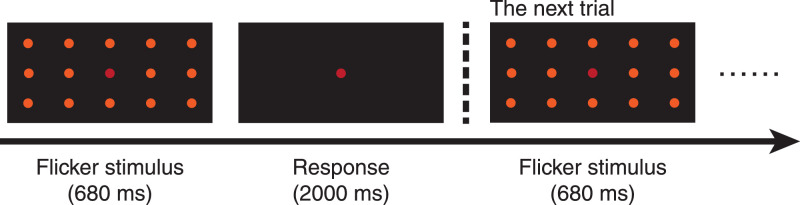
The CFF estimation task in Experiment 1 and Experiment 2.